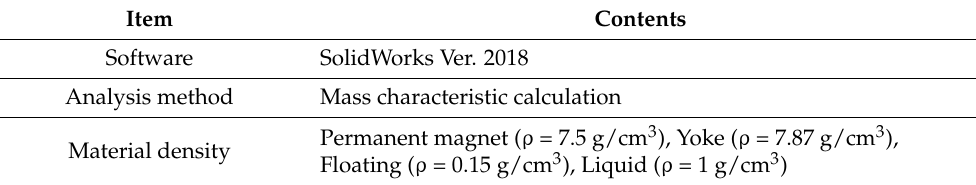
Figure 9. Relationship among the yoke mounting angle, mover tilt angle, and torque. Table 1. Conditions for structural analysis.